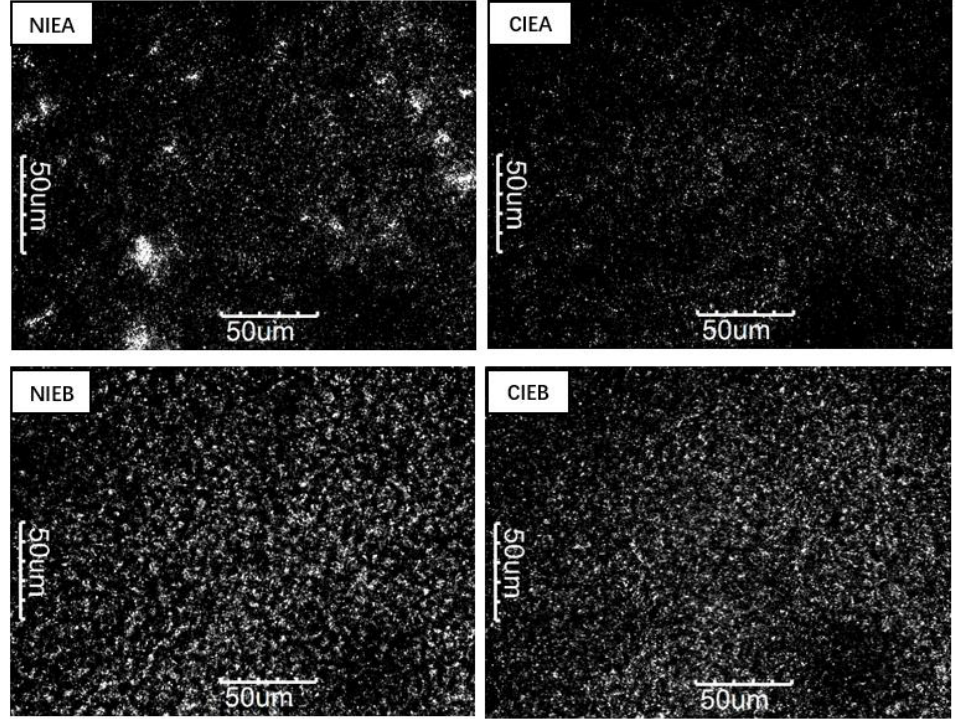
Figure 2. PLM images of NIEA, CIEA, NIEB and CIEB.